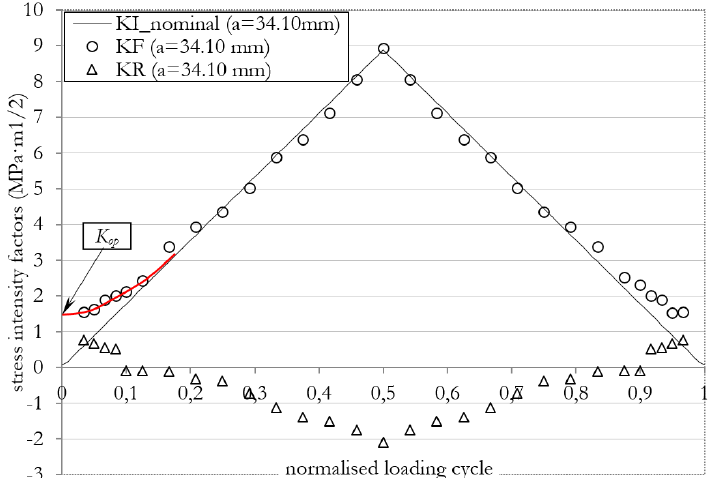
Figure 4: SIFs obtained for the specimen tested at low R -ratio corresponding to a crack length of 34.10